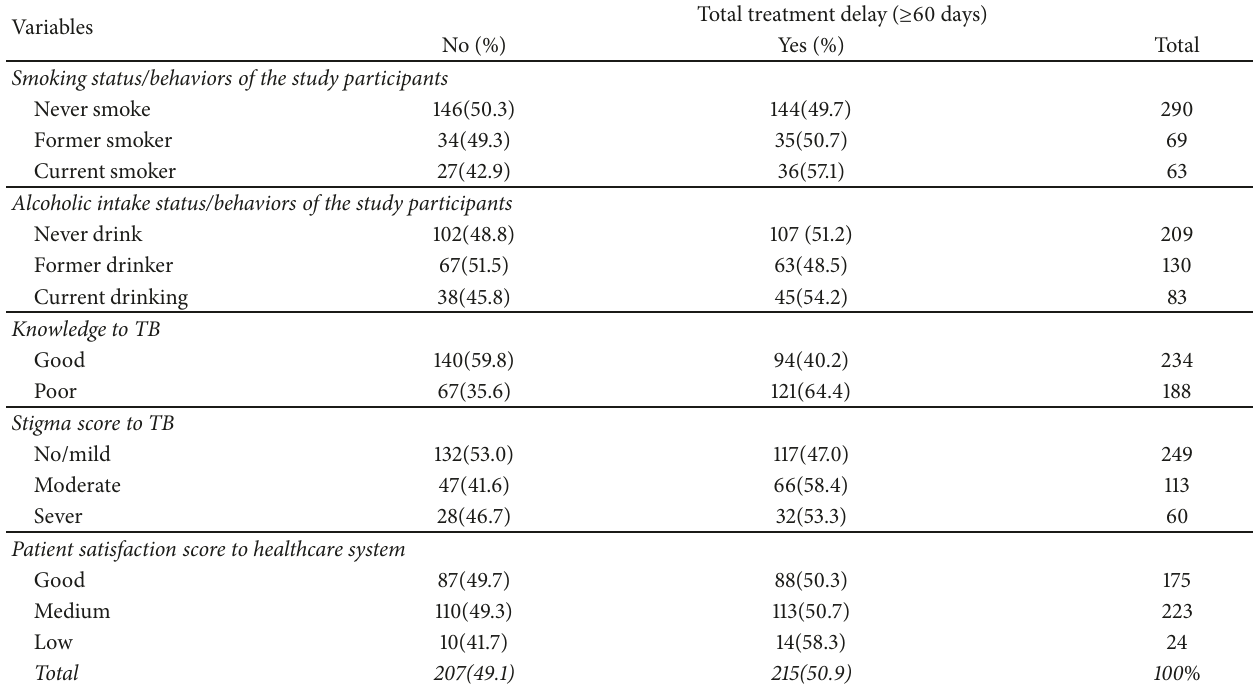
Table 7:Distribution of total delay in treatmentamong behavior& knowledge relatedprofiles of study participants in selectedhealth facilities of Gedeo Zone, Southern Ethiopia,